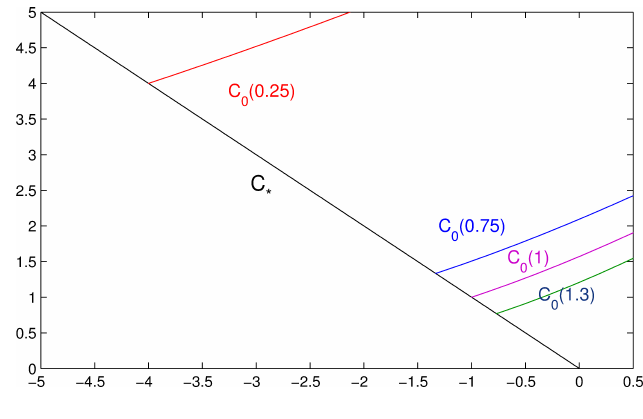
Fig. 2. The members of the D-curves family C 0 .h/ in the parameter space .A 0 ;A 1 / for h D 0:25 , 0:5 , 0:75 , 1 and